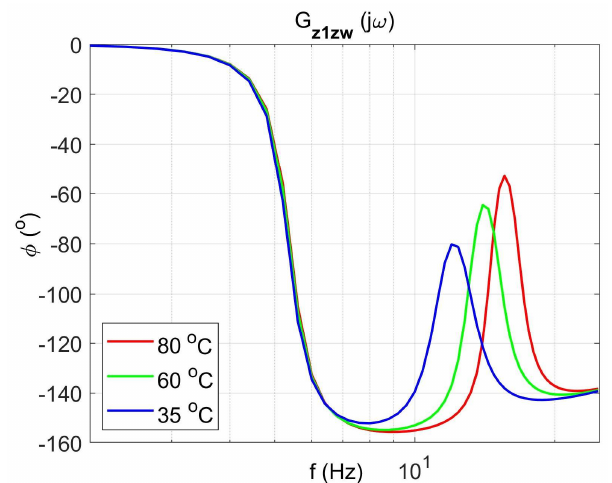
Figure 11. Absorber phase shift as a function of frequency for selected temperatures 25 °C, 60 °C, 80 °C, the transfer function G z 2 zw .